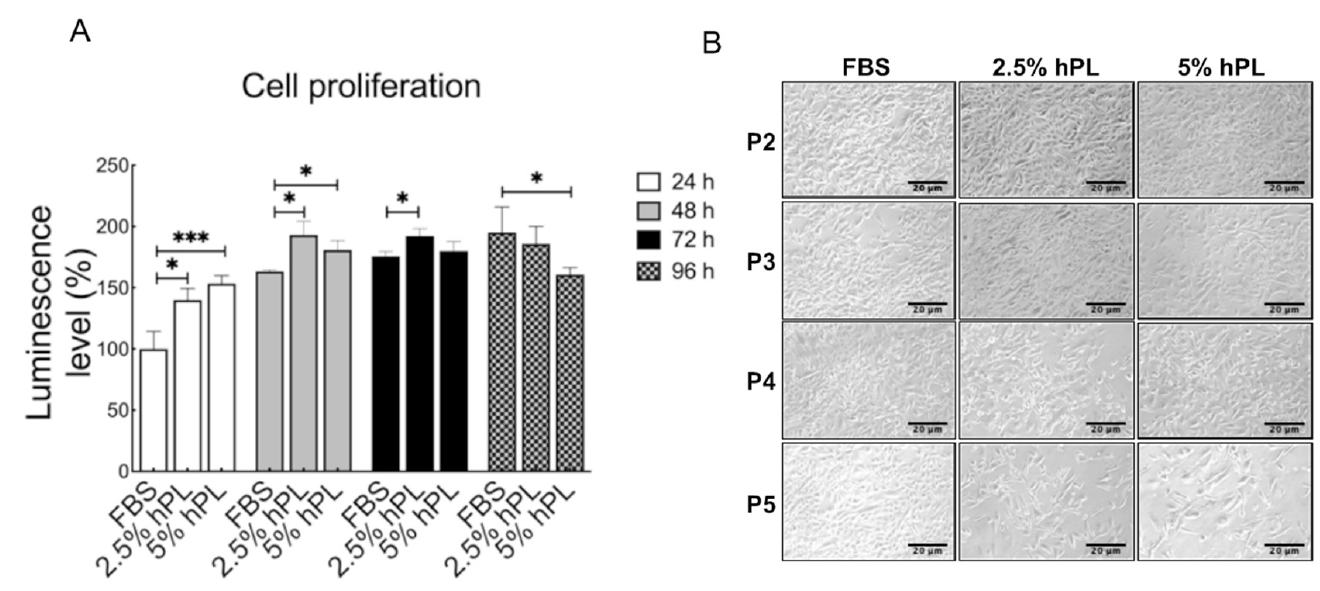
Figure 1. Cell proliferation analysis and morphology observation in GBM cells cultured with FBS and hPL mediums. ( A ) Cell-Titer Glo assay was investigated in GBM cells maintained in FBS, 2.5% and 5% hPL mediums for 24 h–96 h. Data are mean ± SD of five independent experiments. Student’s t -test, *, p < 0.05, ***, p < 0.001. ( B ) The morphology of GBM cells cultivated from passage 2 to passage 5 with FBS, 2.5% and 5% hPL culture mediums. GBM cells were subcultured every 4 days under serum or serum substitute culture mediums, and subcultivation ratio of 1:4 was determined. Scale bar = 20 μ m.